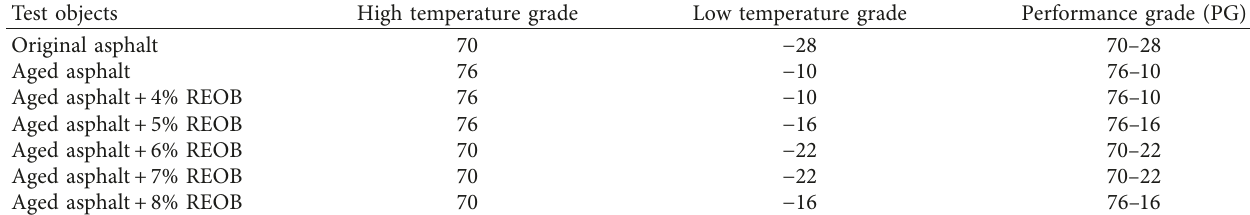
Table 3: Performance grade of different asphalt binders.